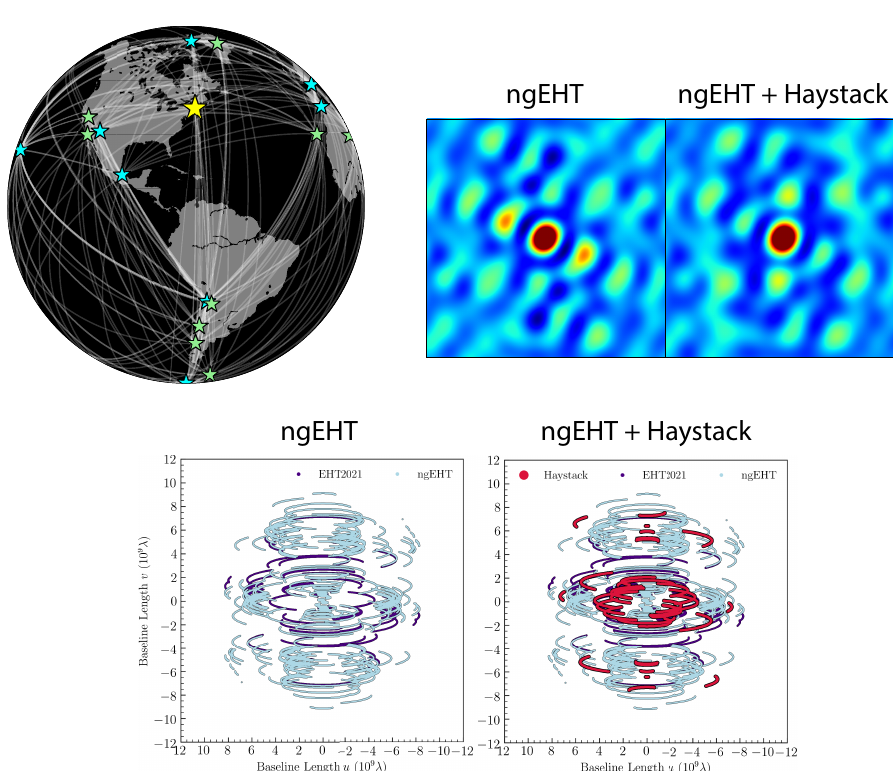
Figure 3. Outline of the impact of observations with the Haystack Telescope on VLBI arrays (K. Akiyama, priv. comm.). The upper left panel illustrates an ngEHT reference array used for imaging simulations, as appropriate for a target at a declination of + 10 ◦ . Specifically, current EHT stations are marked by blue stars, while green stars indicate potential new sites. The Haystack Telescope is marked by a yellow star. This highlights the important role the Haystack Telescope can play in linking VLBI stations across the Atlantic Ocean. The upper right panel characterizes how inclusion of the Haystack Telescope into the adopted ngEHT array improves the synthesized beam. Inner sidelobes are reduced by a factor 1.4. The bottom panel illustrates that adding the Haystack Telescope would in particular help to populate the inner area of the uv